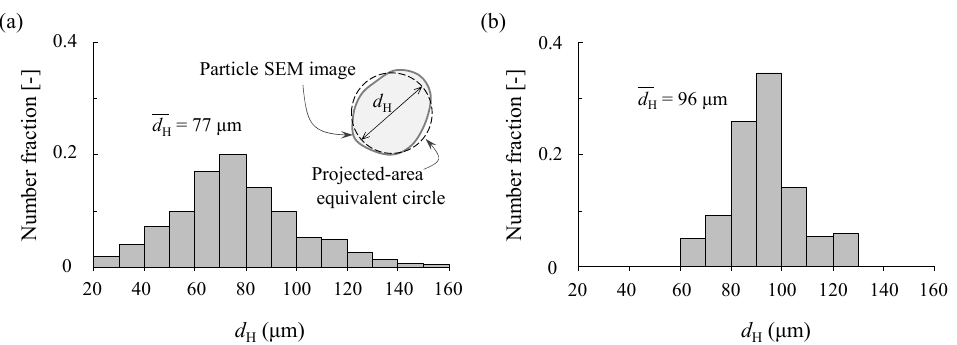
Figure 4. Particle size distribution: ( a ) sample #1 (as-received powder) and ( b ) sample #2 (sieved powder).